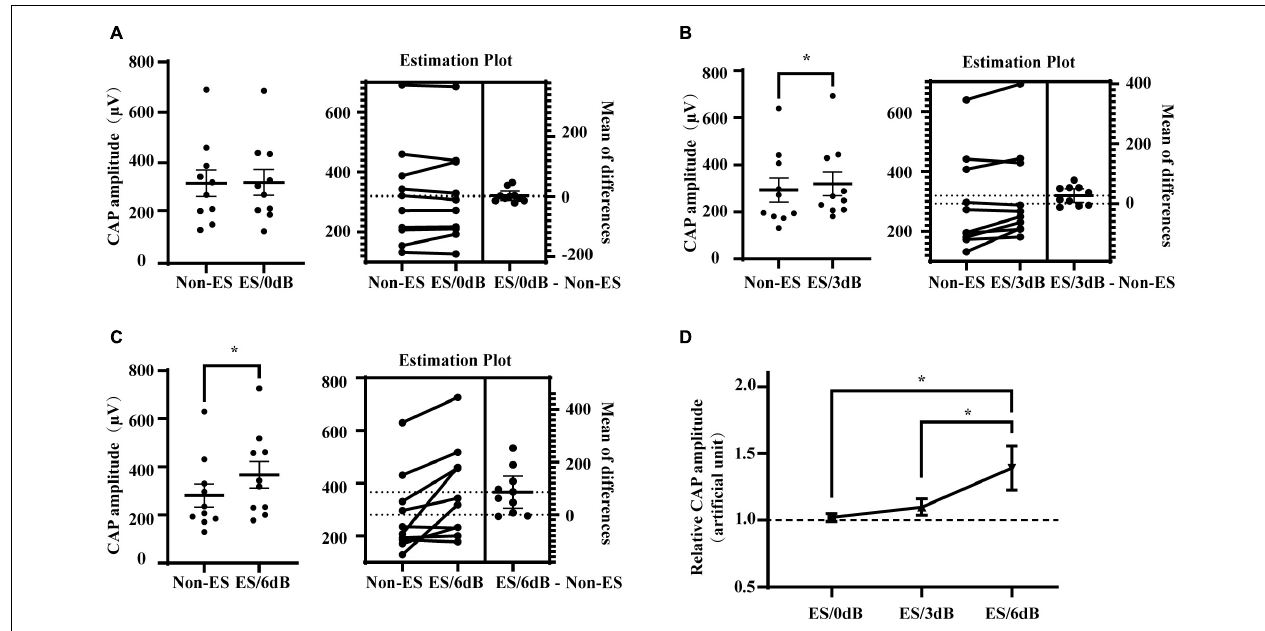
FIGURE 3 | Impact of forward ES intensity on its interference in iECochG of AS. (A) One ms forward 0 dB ES (intensity equal to ECAP threshold) from the most apical electrode did not change CAP amplitudes of the following 4 kHz 20 dB AS, P = 0.6593. (B,C) However, 3 dB (double ECAP threshold intensity) or 6 dB (quadruple ECAP threshold intensity) ES significantly increased CAP amplitudes of following AS, ES/3 dB vs. non-ES, P = 0.0271; ES/6 dB vs. non-ES, P = 0.0114. In (A–C) , each plot means an animal data and the horizontal line means the mean across animals. (D) Relative CAP amplitudes varied with ES intensity, F (2,18) = 4.342, P = 0.0289. Relative CAP amplitudes of AS combined with 6 dB forward ES were significantly higher than that of AS with 3 or 0 dB forward ES, P = 0.0284 or 0.0338, respectively. Non-ES, no electrical stimulation; ES/0 dB, ES with an intensity equivalent to a corresponding ECAP threshold level; ES/3 dB, ES with an intensity of 3 dB above the corresponding ECAP threshold, i.e., the double intensity of ECAP threshold level. ES/6 dB, ES with an intensity of 6 dB above the corresponding ECAP threshold, i.e., the quadruple level intensity of ECAP threshold level. Relative CAP amplitudes were ratios of CAP amplitudes with to without forward electrical stimulation. (A–C) Treated with two-tail paired t test. (D) Treated with RM one-way ANOVA followed by one-tail paired t test multiple comparisons. * P <